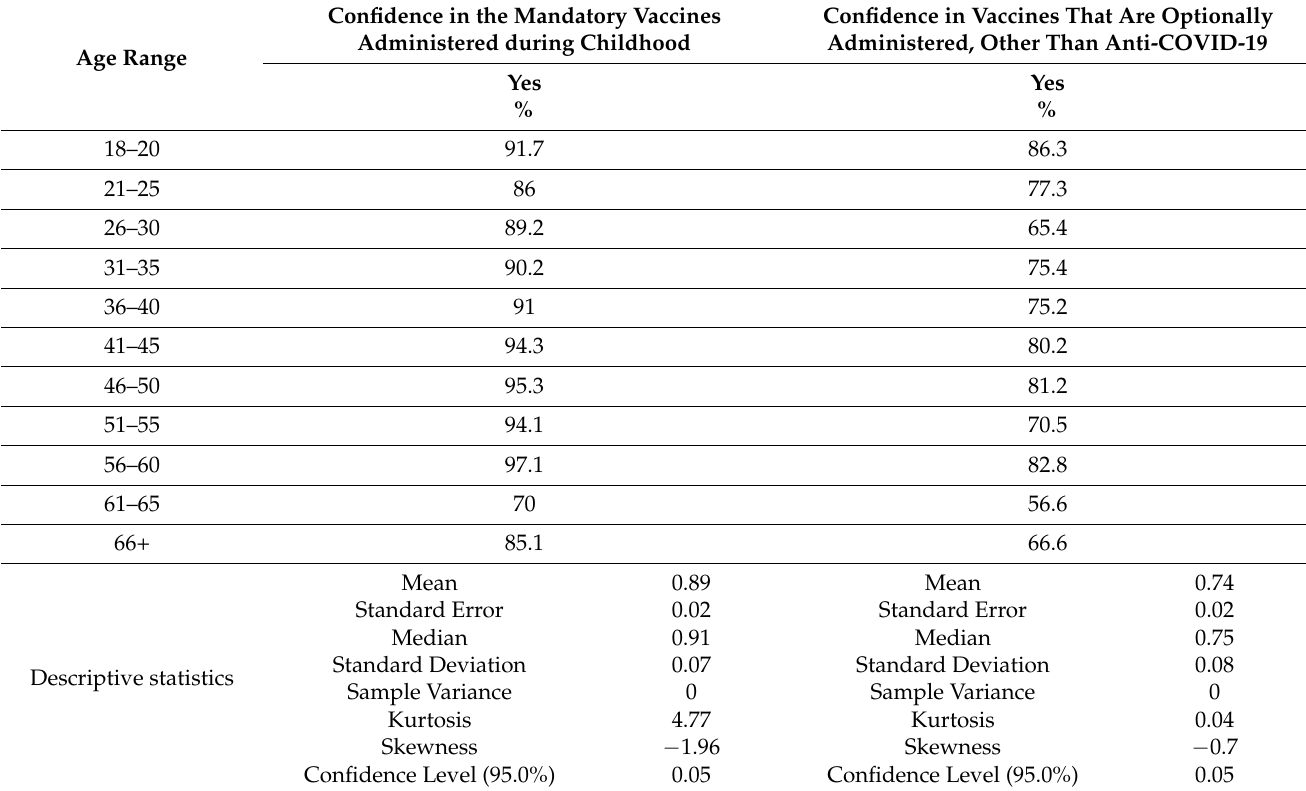
Table 4. Participants’confidenceinvaccinesincludedinthenationalvaccinationschemeandoptionalvaccines.